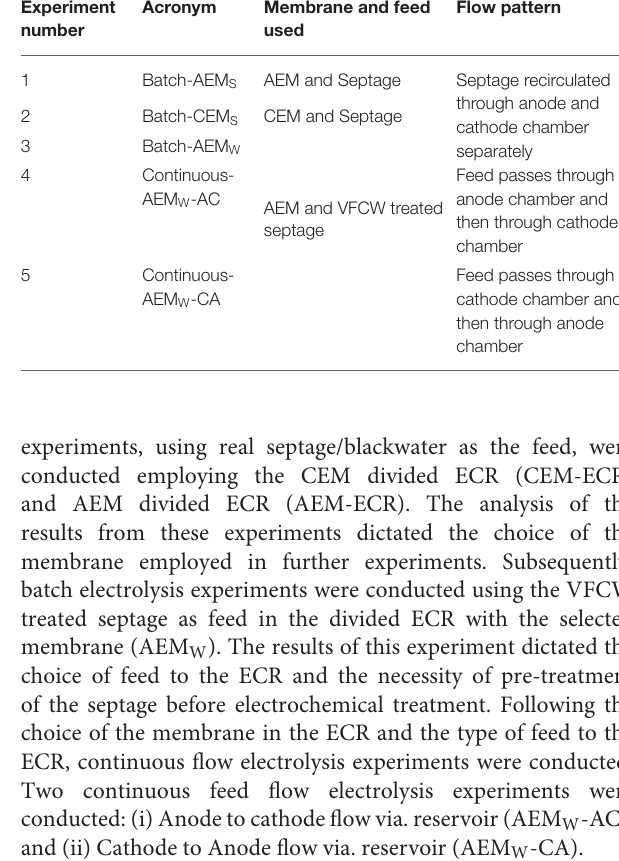
used. The feed was fed and/or recirculated into the reactor using peristaltic pumps (NFP-01, Flowtech, India) with variable flow rates ranging from 0.6 to 100 ml/min. This ECR configuration